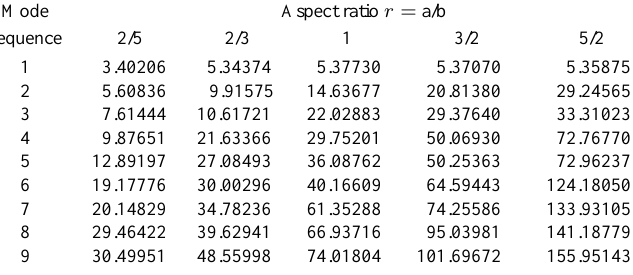
Table 17 Bicubic B-spline solutions of frequency parameters for GFFF